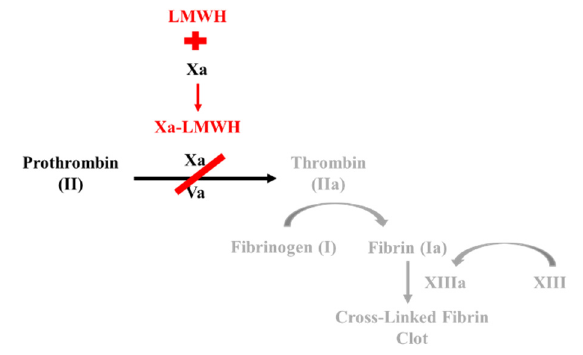
Figure 5. Mechanism of Action for low molecular weight heparin.